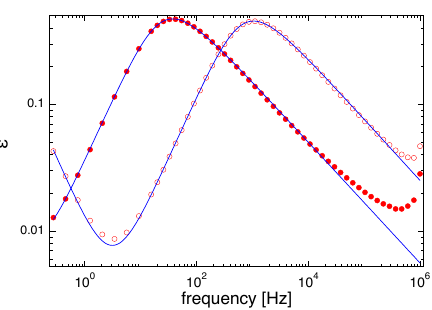
Figure 3. Test fits with a HN-function including conductivity of the α -relaxation peak of glycerol at T = 209 K and T = 219